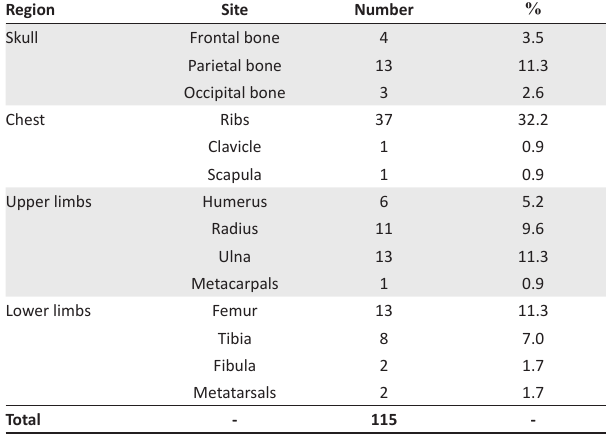
TABLE 2: Fractures according to region and site.